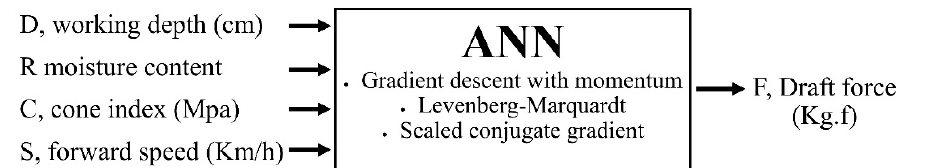
Figure 5. The artificial neural network (ANN) used in this study.